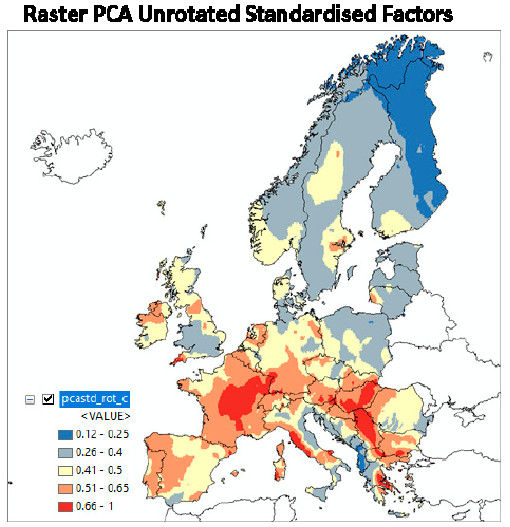
Figure 10. GRHI map derived from the first principal component (From [30]).